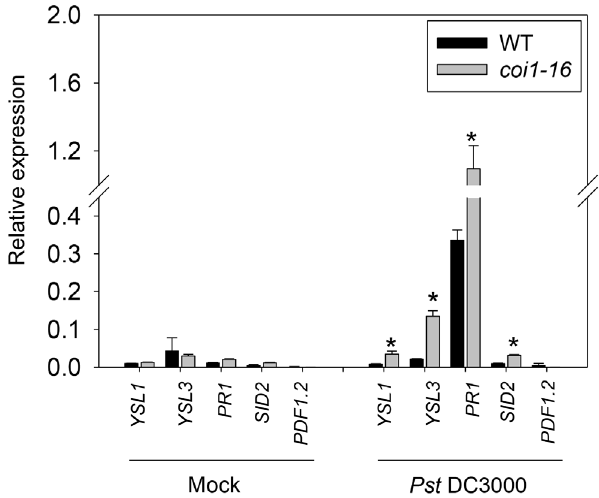
Figure 5. Effect of CORONATINEINSENSITIVE1 mutation ( coi1 ) on the expression of YSL1, YSL3 , SID2 , PR1 and PDF1.2 in Arabidopsis leaves inoculated with Pst DC3000. Four-week-old A. thaliana ecotype Col-6 wild type (WT) and coi1-16 mutant were spray- inoculated with Pst DC3000 solution. Plants sprayed with 10 mM MgCl 2 with 0.02% Silwet L-77 were used as a mock treatment control. Mature leaves (3th) were harvested at 3 dpi. qPCR analysis of expression of YSL1, YSL3, PR1, SID2 and PDF1.2 relative to that of ACT2 . Data are mean 6 SD from 6 samples of 2 biological repeats. *P , 0.05 compared with wild